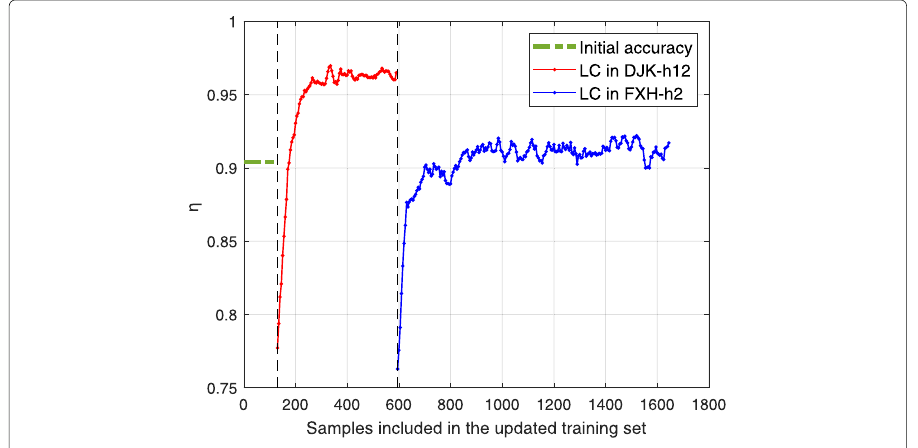
Fig. 13 The learning curve of A- k NN AMC classifier ( k =